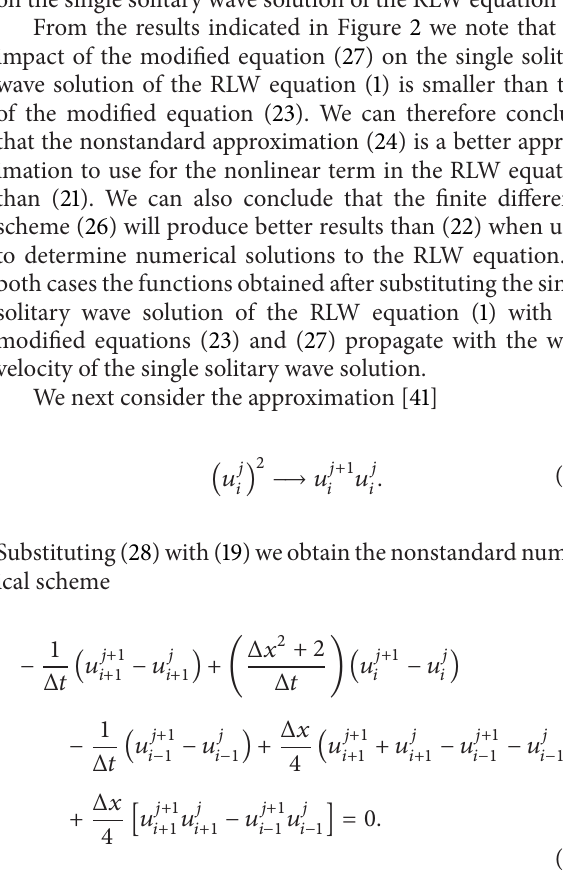
Figure 1 propagate with the wave velocity of the single solitary wave solution (8) maintaining a constant wave